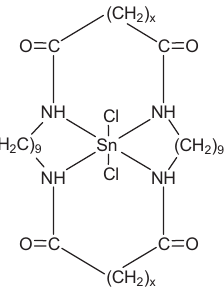
Figure 1 Structures of the tin(II) complexes according to the results of the spectral studies. x = 1, 2, 3,